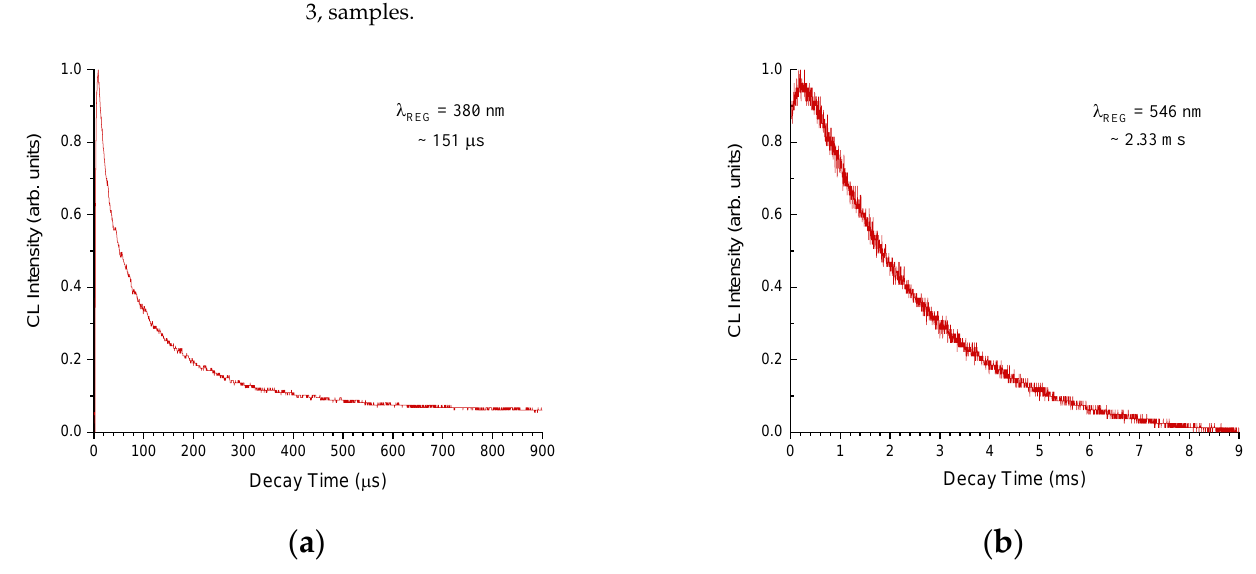
Figure 6. Room temperature scintillation kinetics of GYAGG:Tb, Tb = 0.15, in the spectral range of the transitions: ( a ) 5 D 3 → 7 F J (380 nm); ( b ) 5 D 4 → 7 F J ; (546 nm). The scintillation, which is caused by the 5 D 3 → 7 F J transition, is strongly quenched by the nonradiative transfer from the 5 D 3 to the 5 D 4 state. As a result, there is a rising part in the kinetics of the scintillation in the spectral range of the 5 D 4 → 7 F J transition with a con- stant of 150 μ. At a low excitation intensity, ~0.1 A/cm 2 , the scintillation kinetics is close to that of photoluminescence; however, upon highest excitation, the decay constant de- creases by ~20%, which is due to additional quenching. Figure 7 shows the dependences of the scintillation yield on the excitation intensity of GYAGG:Tb Tb = 0.15 and GYAGG:Ce measured at room temperature.